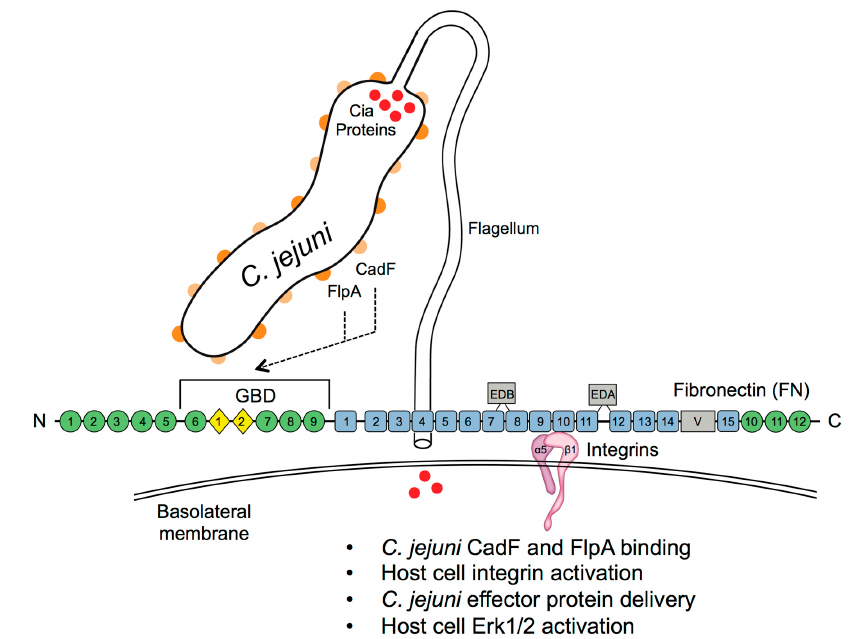
Figure 10. A model of C. jejuni interaction with host cells. C. jejuni drives the host cell processes by forming the three-component bridge between the CadF and FlpA proteins, host cell-associated fibronectin (FN), and α 5 β 1 integrin. While only a single FN molecule and a single α 5 β 1 integrin are shown for simplicity, C. jejuni- induced host cell signaling requires multiple FN molecules and the occupancy and clustering of multiple α 5 β 1 integrin heterodimers for the maximal stimulation of cellular signaling pathways. FN is composed of 12 FN type I repeats (FN I, green circles), 2 FN type II repeats (FN II, yellow diamonds), and 15–18 FN type III repeats (FN III, blue squares). Additionally, Extra Domains A and B (EDA and EDB) are shown and the variable (V) region that connects two type III repeats. Both CadF and FlpA proteins bind to the 45 kDa N-terminal domain (NTD) of FN that harbors the gelatin-binding domain (GBD). However, CadF and FlpA likely bind to different regions of the 45 kDa fragment based on ELISAs performed in the presence or absence of 4 M urea (see the text for details). Intimate contact between C. jejuni and the host cells by CadF and FlpA facilitates the delivery of the C. jejuni e ff ector protein CiaD, which is necessary for Erk 1 / 2 activation. Together, CadF and FlpA set the stage for host cell invasion by binding to FN associated with the α 5 β 1 integrins on the basolateral surface of cells (sites of focal adhesions) and to deliver e ff ectors that stimulate host cellular signaling